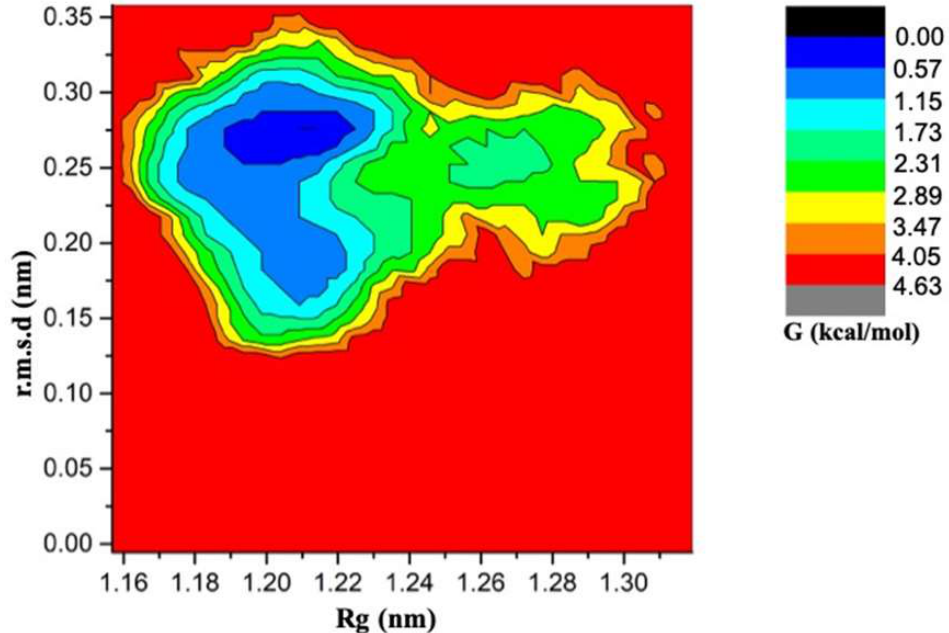
Figure 5. The Free Energy Landscape (FEL) between radius of gyration (X-axis) and r.m.s.d (Y-axis). The computed Gibbs free energy values are represented by colored contours.